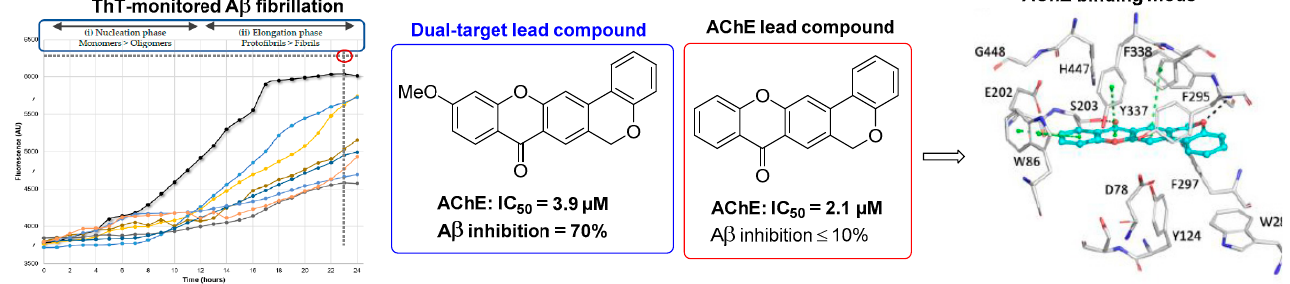
Figure 1. Chromeno[3,4- b ]xanthones as first-in-class AChE and A β aggregation Figure 13. Chromeno[3,4- b ]xanthones as first-in-class AChE and Aβ aggregation inhibitors.